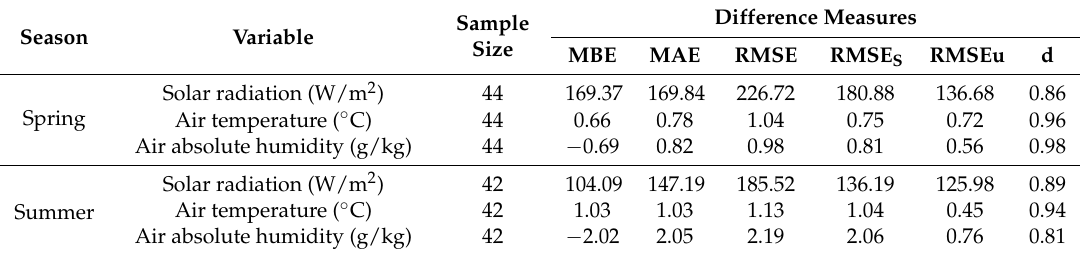
Figure 4. Comparison of modeled and observed solar radiation in treeless areas: ( a ) in spring ( b ) in summer. Table 4. Quantitative measures of ENVI-met model performance with observed data in treeless sites *.